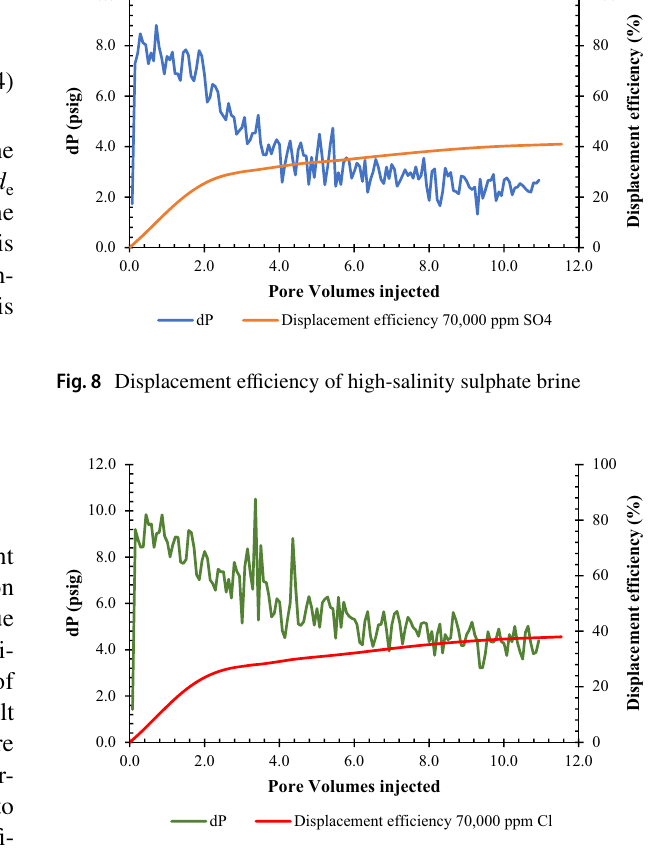
Fig. 9 Displacement efficiency of high-salinity chloride-based brine at test